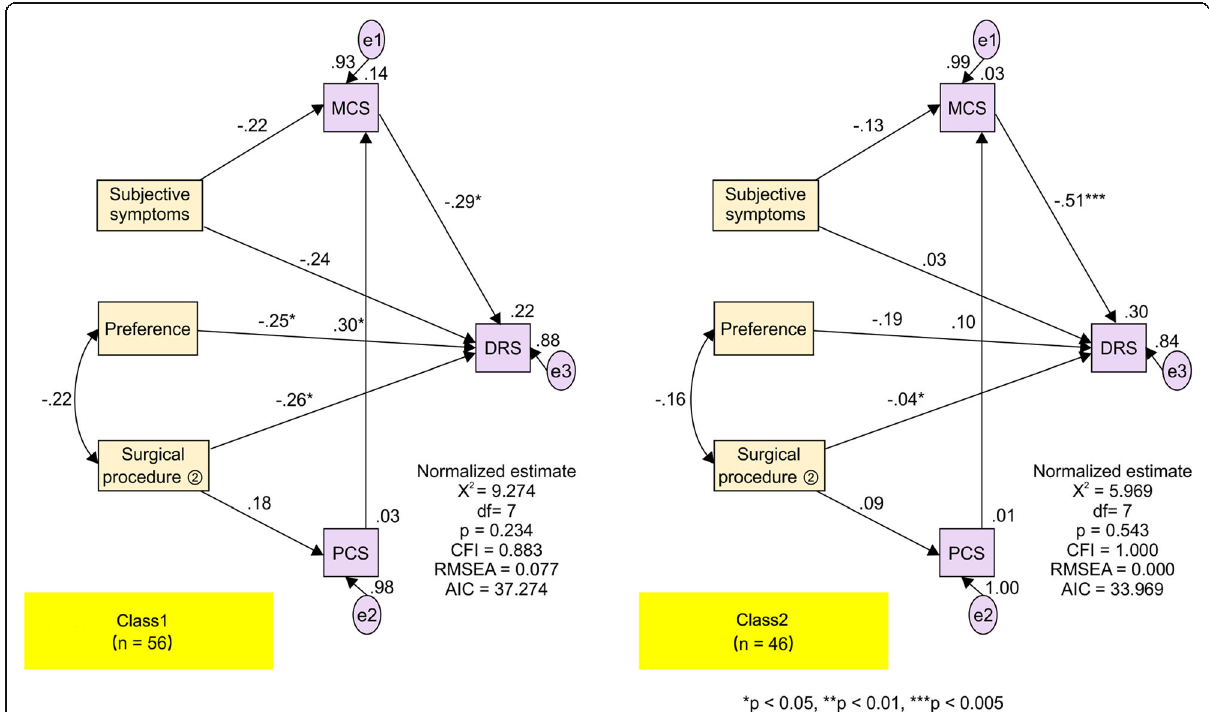
Fig. 4 Multi-Group Analysis. Subjective symptoms (0 Not present, 1 present), Preference (0 Not present, 1 present), and Surgical procedure (2) (0 laparotomy, 1 laparoscopic surgery). MCS, Mental component summary; PCS, Physical component summary; DRS, Japanese version of the Decision Regret Scale; df, degrees of freedom; CFI, comparative fit index; RMSEA, root mean square error of approximation; AIC,